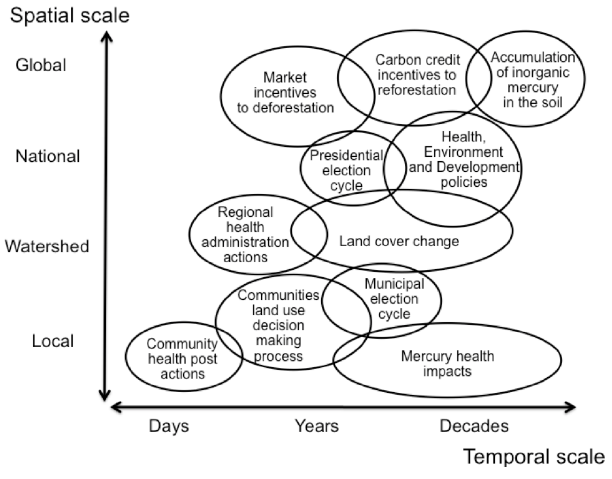
Fig. 1. Interactions across spatial and temporal scales for mercury exposure in the Brazilian Amazon